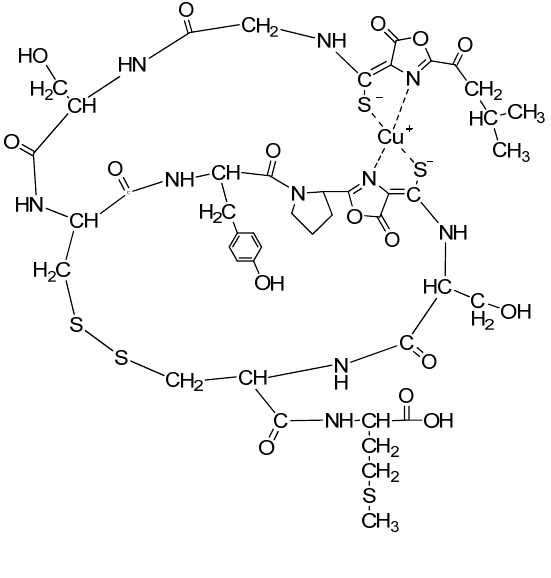
Figure 1. Proposed structure of Mb-Cu from Methylosinus trichosporium OB3b